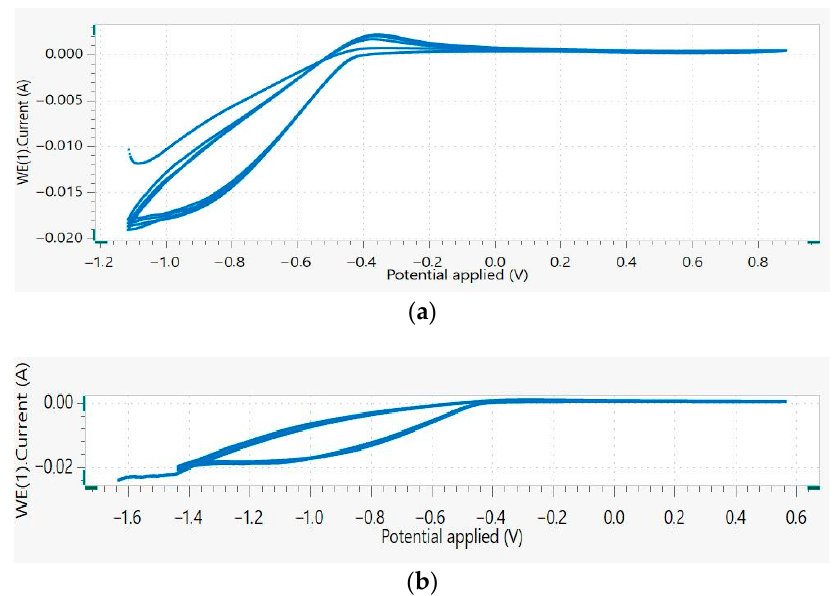
Figure 11. CV voltammograms of CV vs. Ag.AgCl for ( a ) M6 and ( b ) M8 at the end of open-circuit operation.